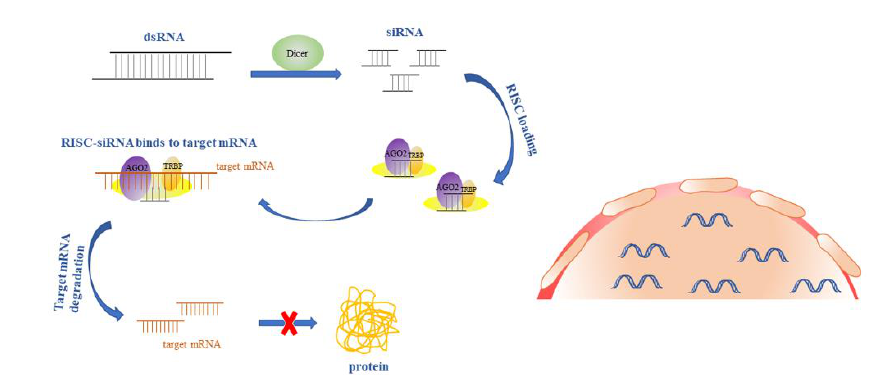
Figure 1. Mechanisms of siRNA-mediated gene silencing.